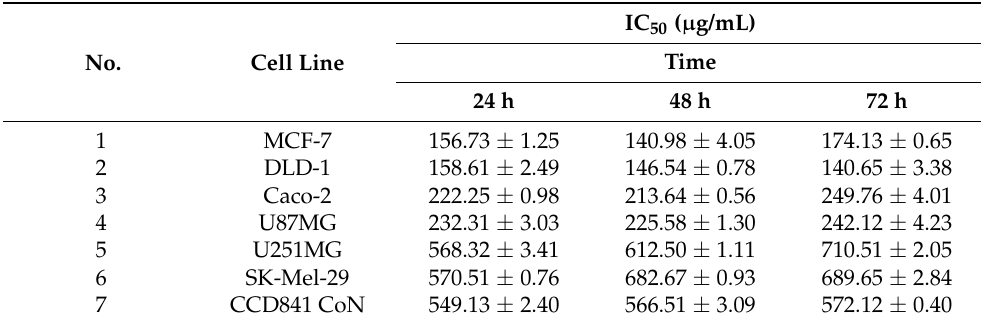
Table 3. IC 50 ( µ g/mL) values for the examined J. regia pollen extract on the viability of seven human cell lines, after 24, 48, and 72 h of